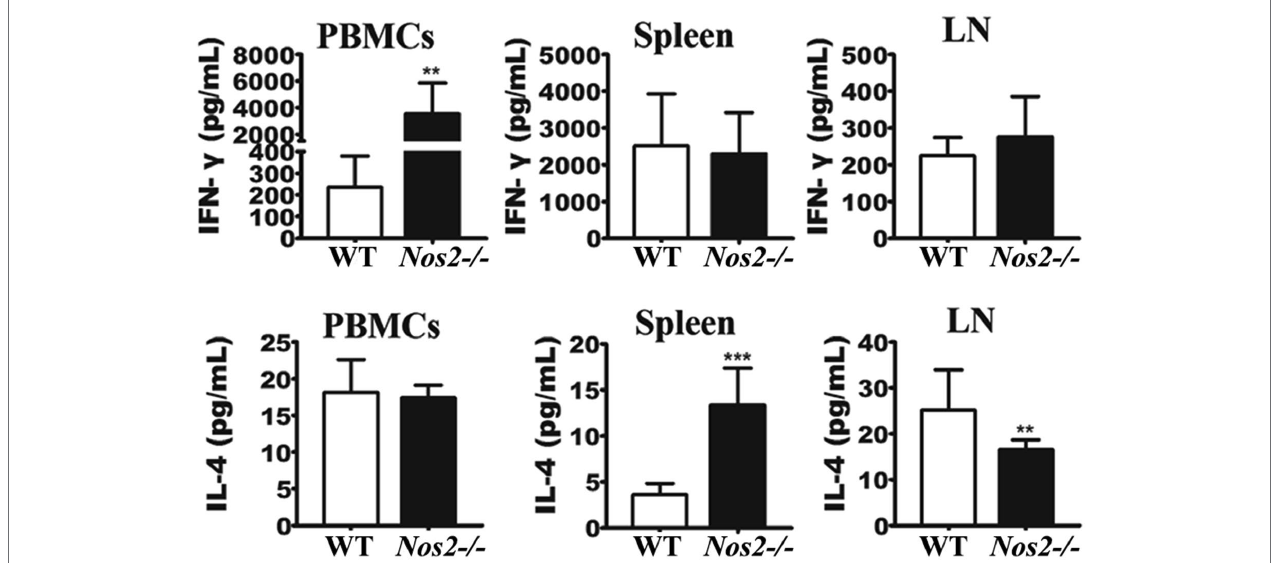
FIGURE 3 | IFN- γ and IL-4 production in rat immune cells stimulated with SLA. 2 × 10 5 PBMCs, LN, and spleen cells were isolated and treated with 50 μ g/ml soluble Leishmania antigens (SLA); IFN- γ and IL-4 production were determined from culture supernatants at 48 h post-treatment ( N = 6, mean ± SD). ** indicates a significant difference (0.001 ﹤ P ﹤ 0.01);*** ( P ﹤